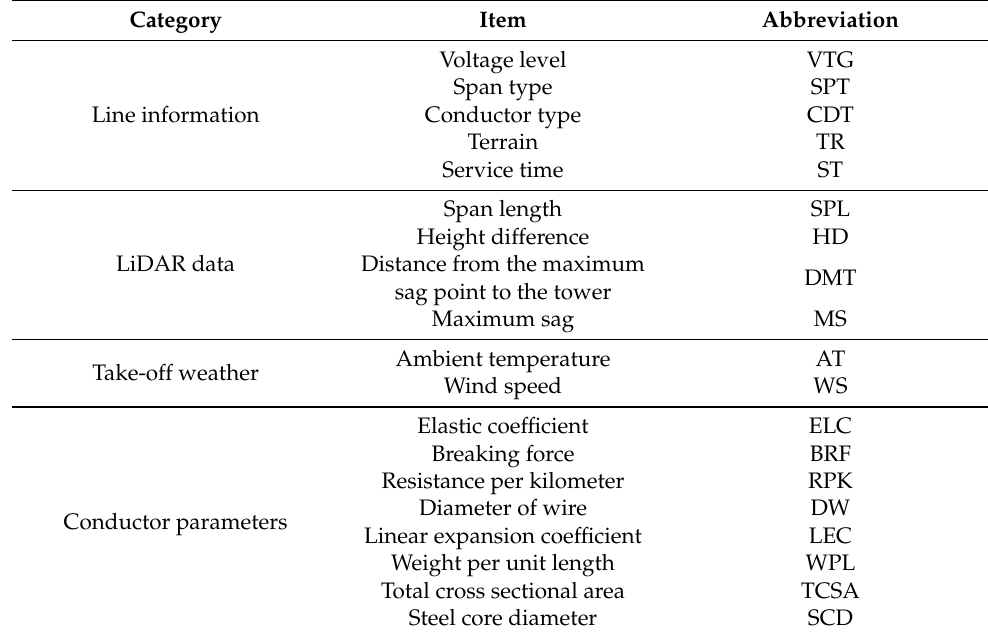
Figure 1. Helicopter-borne laser scanning inspection operation. Table 2. The selected features and their